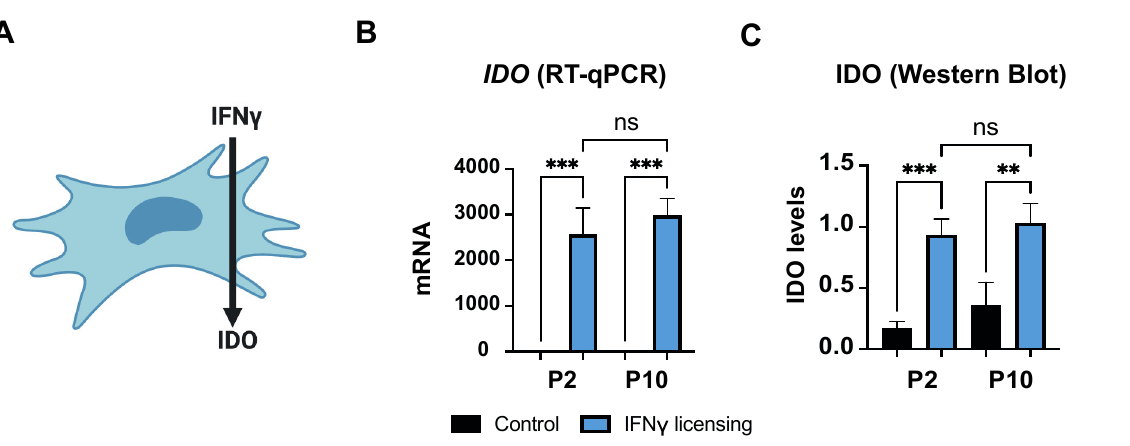
Figure 3. Effect of IFNγ on HF-MSCs. ( A ) IFNγ induces expression of IDO in human MSCs. ( B , C ) Representation of IDO gene expression levels in HF-MSCs by ( B ) qRT-PCR and IDO protein levels in HF-MSCs by ( C ) Western Blot. Each datapoint represents the mean for at least three wells ± SD. Statistical significance: *** p < 0.001 ** p < 0.01, ns, no significant difference p > 0.05. IFNγ interferon gamma. IDO, indoleamine 2,3-dioxygenase. P2, passage 2. P10, passage 10.